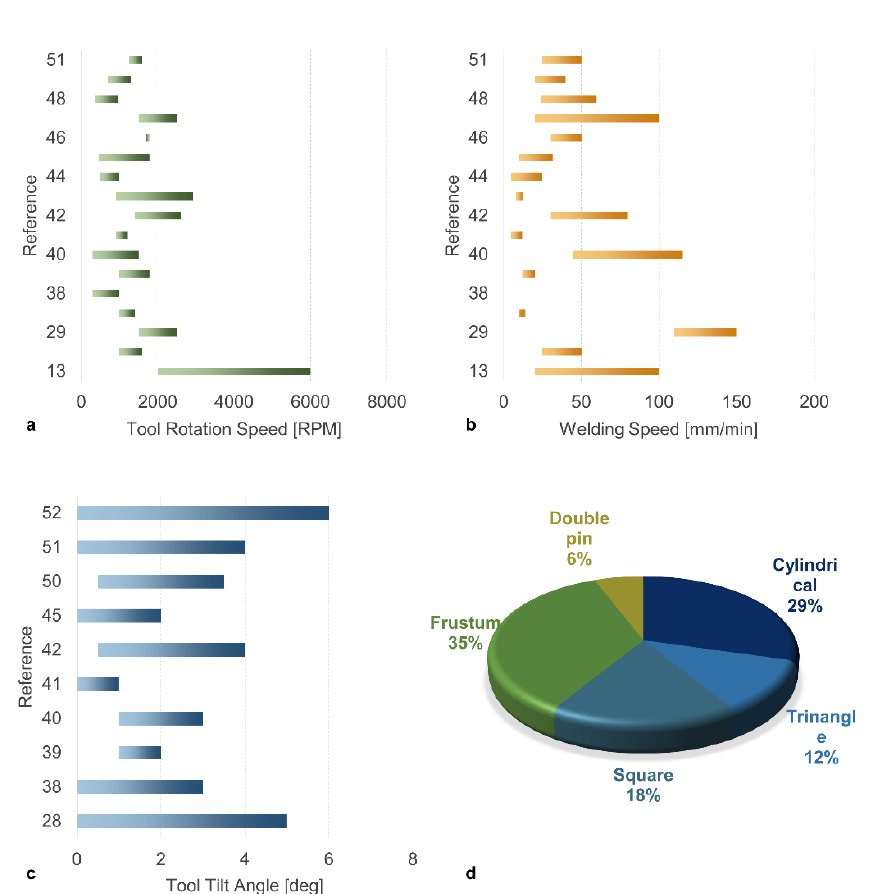
Figure 12. Processing windows analyzed in different papers concerning FSSW of polymers. Effect of: ( a ) tool rotation speed; ( b ) welding speed; ( c ) tool tilt angle ( d ) shape of pin.